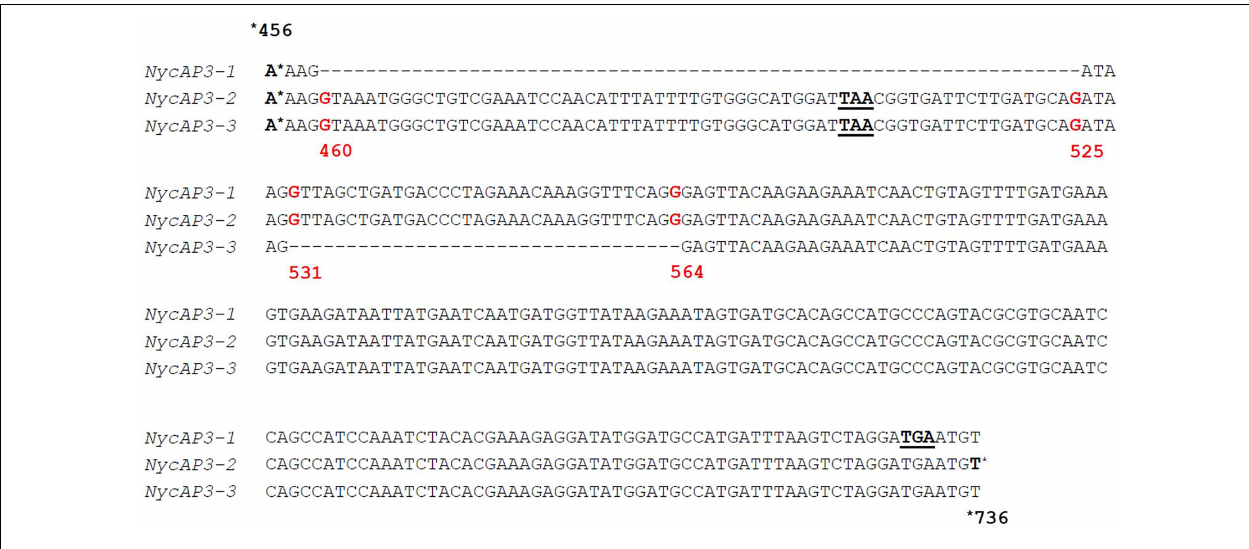
FIGURE 2 | Partial alignment of the three NycAP3 transcripts isolated in this work and annotated as NycAP3-1 , NycAP3-2 , and NycAP3-3 . The alignment shows the regions where the differences among the three sequences are situated. STOP codons are underlined. Red numbers refer to nucleotide positions on the NycAP3-2 sequence from the start ATG. The alignment was built in accordance with Stellari et al. (2004).